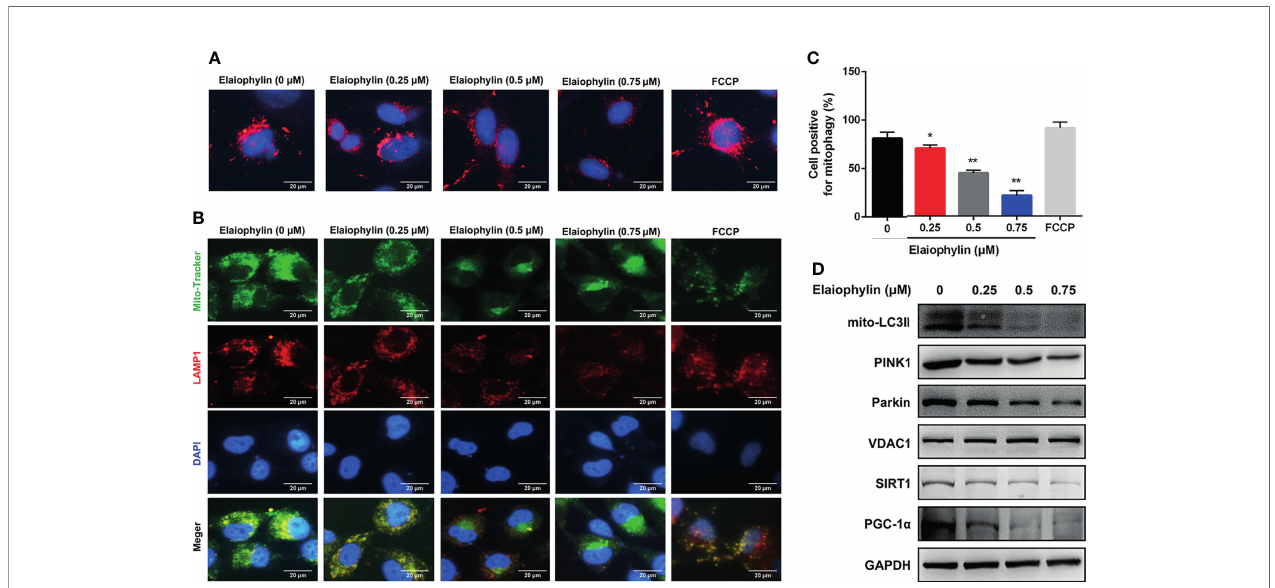
FIGURE 3 | Elaiophylin inhibits mitophagy in C918 cells. (A) C918 cells overexpressing Mito-Keima plasmid was treated with Elaiophylin for 24 h. Mito-Keima (red fl uorescence) was detected by a fl uorescence microscope. FCCP, a mitophagy agonist, was used as positive control. (B) Colocalization of mitochondria and lysosomes. Mitochondria were stained with MitoTracker Green (200 nM), and lysosomes were stained with LAMP1 (red fl uorescence). The representative images of fl uorescent labeling were shown here. (C) Quantitative analysis of cellular mitophagy of (B) was conducted with Image J software. Five different visual fi elds of each group were selected for measurement. (D) Western blotting was performed to analyze the expression of proteins related to mitophagy. GAPDH and VDAC1 were used as loading controls for cytoplasm and mitochondria, respectively. Data was expressed as mean ± SD of three experiments. * p <0.05, ** p <0.01 vs.